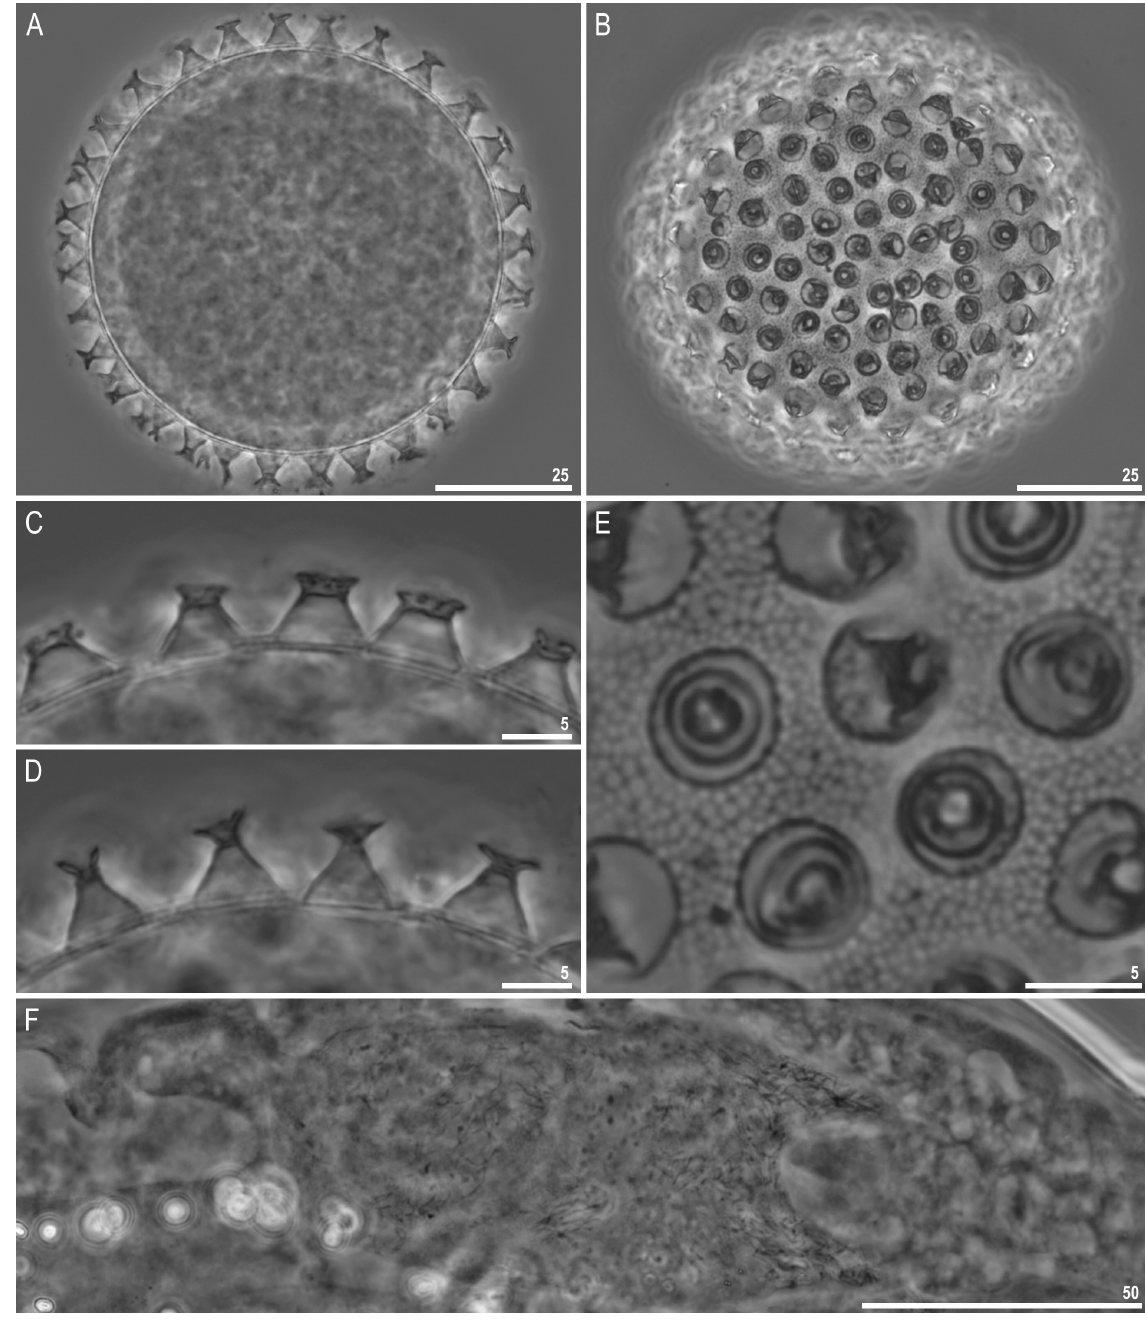
Fig. 14. Macrobiotus kamilae sp. nov. A–E . Egg seen in PCM (IZiBB). A . Midsection under 400× magnification. B . Surface under 400 × magnification. C–D . Midsection under 1000 × magnification. E . Surface under 1000 × magnification. F . Male testis seen in PCM, with visible spermatozoa in